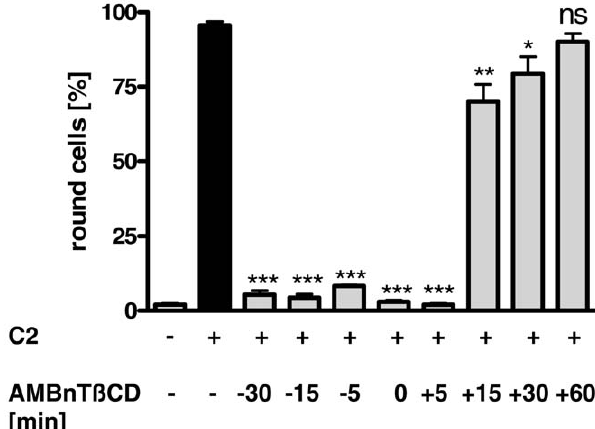
Figure 3. The time point of AMBnTßCD application determines the protective effect of this compound against intoxication of Vero cells with C2 toxin. Vero cells were grown in 24-well plates and AMBnTßCD (10 m M) was applied to the cell medium either 30, 15 or 5 min before C2 toxin (200 ng/ml C2IIa + 100 ng/ml C2I) was added to the cells or AMBnTßCD was added together with the toxin into the medium. In parallel, AMBnTßCD was added to the cells 5, 15, 30 or 60 min after the toxin. For a control, cells were treated with medium alone or with C2 toxin in the absence of AMBnTßCD. The cells were incubated for 3 h at 37 u C and pictures were taken to determine the percentages of round cells. Values are given as mean 6 S.D. (n=3) and significance was tested for each sample treated with C2 toxin and AMBnTßCD against cells treated with C2 toxin only using the student’s t-test (***p , 0.0005; **p , 0.005; *p , 0.05; n. s.=not significant).